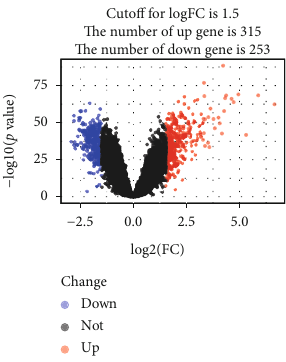
Figure 1: Identi fi cation of DEGs from three datasets using volcano plot analysis. Statistically signi fi cant DEGs were identi fi ed as those with a t -test P value < 0.05 and a ½ logFC (cid:2) > 1 : 5 . The blue dots represent downregulated DEGs, while the red dots represent upregulated